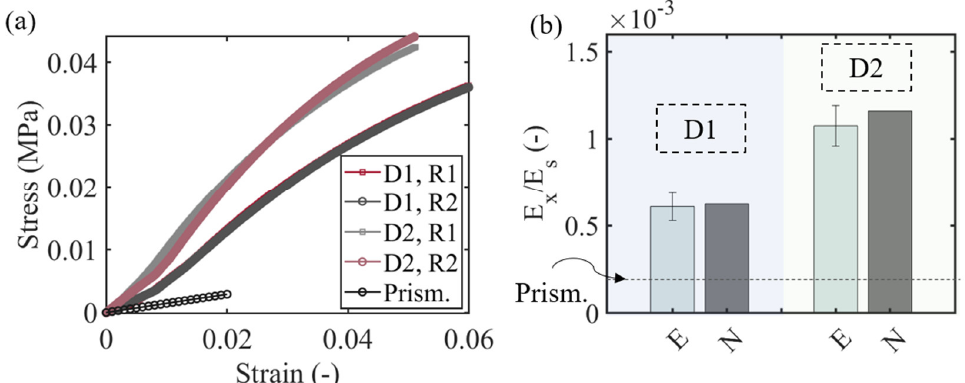
Figure 6. Experimental stress-strain response of multiscale honeycombs with two distinct inner element profiles, along with the reference prismatic design case ( a ). Relative stiffness increases with respect to the prismatic, single-scale configuration for each of the multiscale, variable-section honeycomb design cases -experimental (E) and numerical (N) results ( b ).